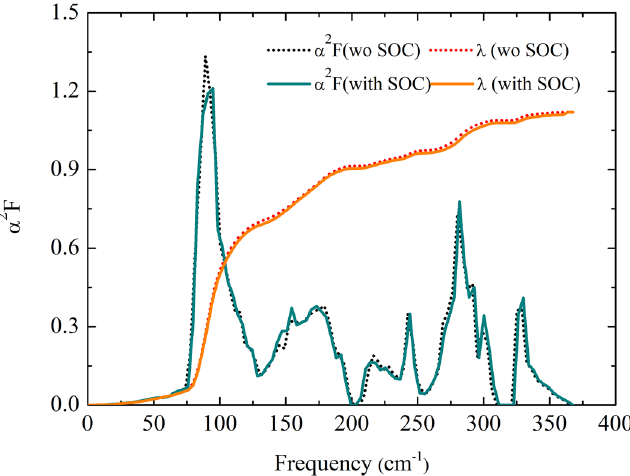
2 F Figure 4. Eliashberg spectral function α ( ω ) and the integrating of lambda (cid:31) in the Nb(Se 0.5 S 0.5 ) 2 structure, where the dotted-black line (the solid-green line) and the dotted-red line (the solid-orange line) represent α ( ω ) and (cid:31) with spin-orbit coupling (without spin-orbit coupling).